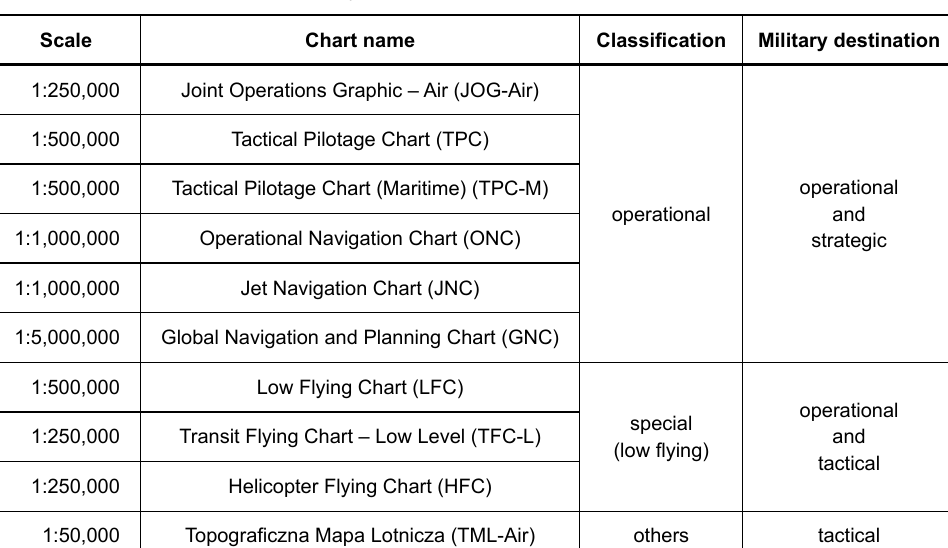
Topograficzna Mapa Lotnicza